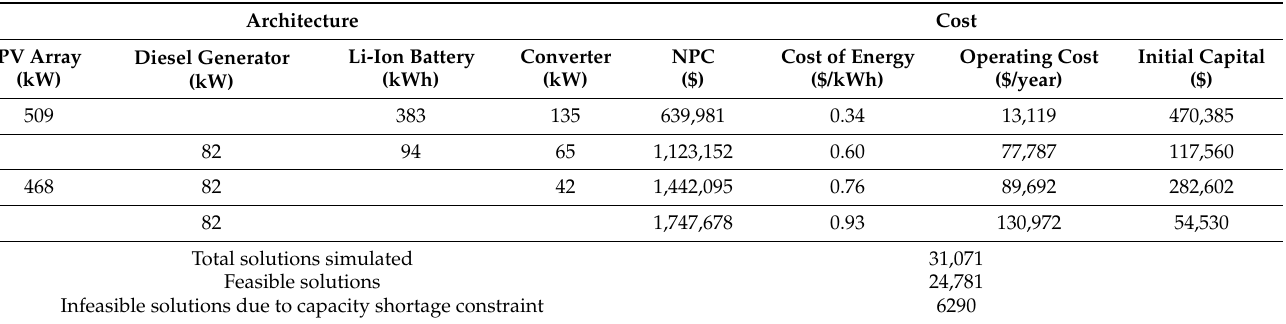
Table 9. Optimal configurations evaluated by the HOMER